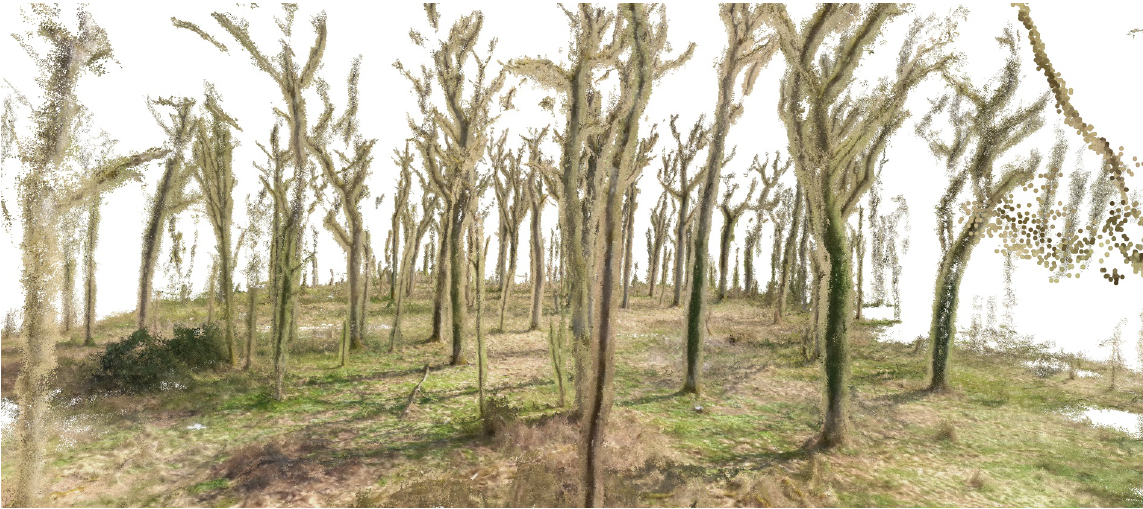
Figure 5: View into the cleaned SFM-point